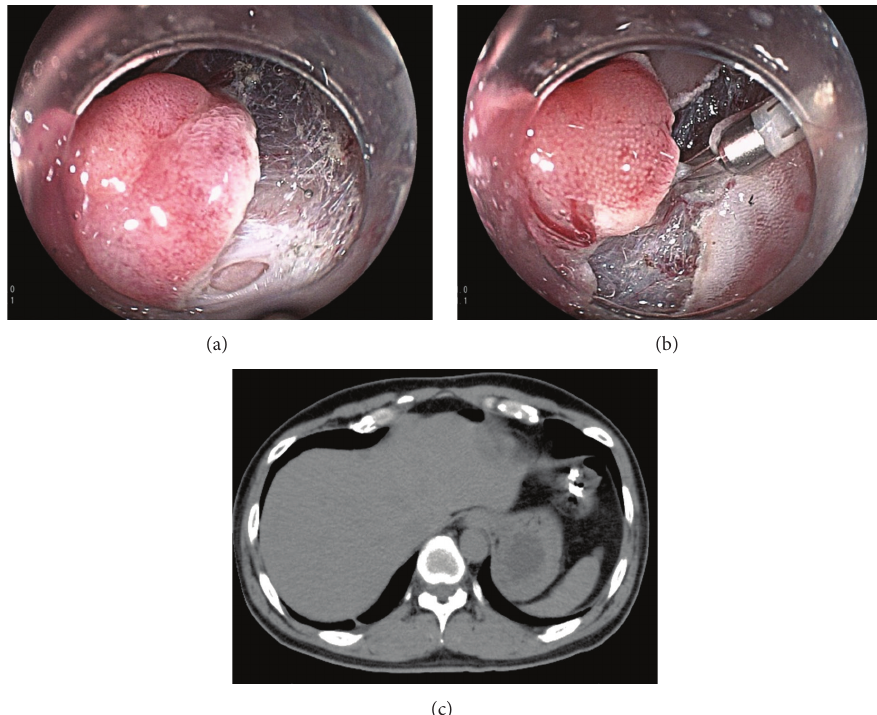
Figure 4: (a) Perforation during dissection. (b) The perforation was closed by endoscopic clipping. (c) Computed tomography revealed the presence of free air outside of the colorectum.